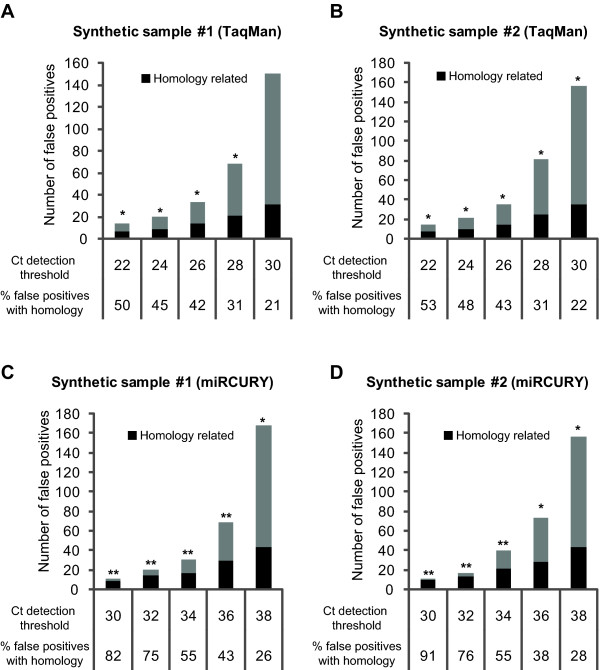
Assessment of the platforms ability to discriminate miRNAs with close sequence homology. Using the synthetic samples, with known miRNA content, it was investigated how many of the false positives detections (miRNAs not in the sample) at a given Ct detection threshold could be related to sequence homology to a miRNA in the sample. Plotted are the number of false positives detected in the synthetic samples at given Ct detection thresholds and it is indicated how many of these can be related to sequence homology. (A, B) TaqMan analysis of synthetic samples #1 and #2. (C, D) miRCURY analysis of synthetic samples #1 and #2. A Poisson randomness test was used to evaluate if the fraction of homology related false positives at a given Ct detection threshold was significantly higher than expected. The expected fraction was defined as the number of potential false positives (the number of assays on a given platform targeting miRNAs not present in the investigated sample) that have sequence homology to miRNAs in the sample. As the synthetic samples #1 and #2 contain the same miRNAs (but in different concentrations) the expected fraction is the same for the two samples. For the TaqMan platform the expected fraction is 93 out of 565 (16%) miRNAs and for the miRCURY platform it is 102 out of 552 (18%). **p < 0.0001, *p < 0.05.